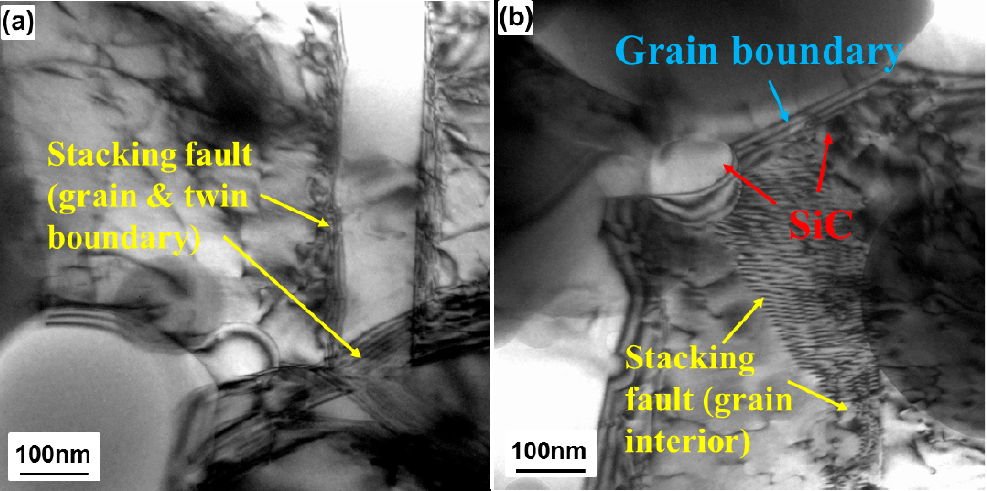
Figure 12. Bright-field TEM images of dislocation motions inhibited by ( a ) grain & twin boundary and ( b ) SiC, Ni 3 Si and grain boundary in the tensile tested 48-h-milled NiMo-0.5% SiC DPS alloy.